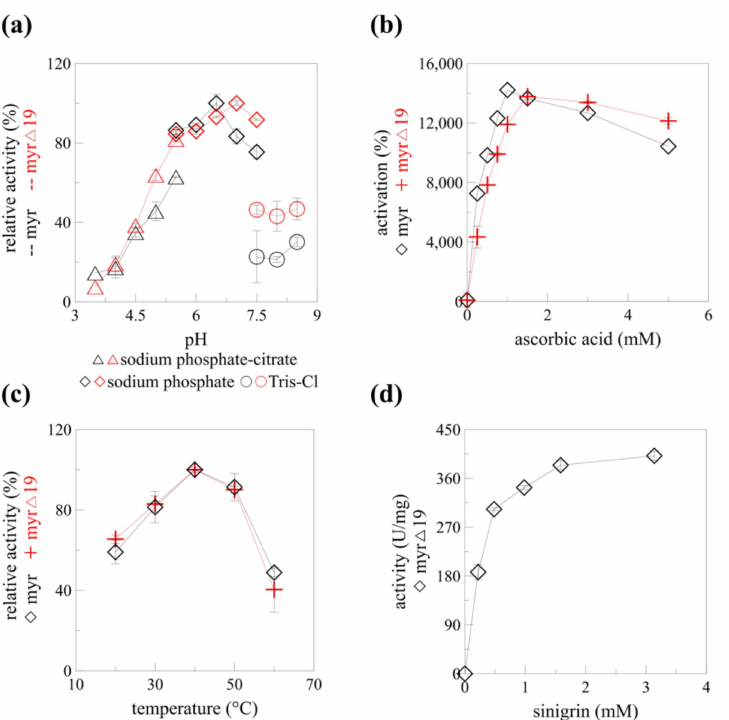
Figure 6. The enzyme characteristics of myrosinase before ( myr ) and after ( myr - ∆ 19) native signal sequence deletion. ( a ) pH profile, ( b ) ascorbic acid-dependent activation, ( c ) temperature profile of myr [13] and myr - ∆ 19. ( d ) Kinetics of myr - ∆ 19 with different concentrations of sinigrin and 1.5 mM of ascorbic acid as activator, measured at 40 ◦ C, pH